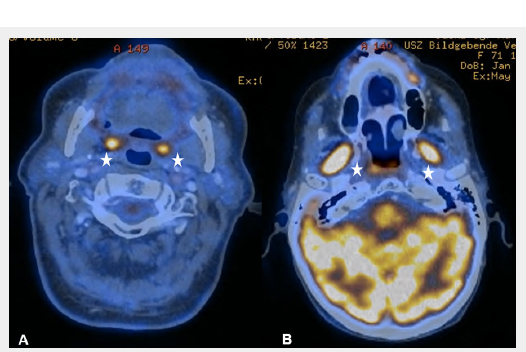
(A) Bilateral physiological uptake in the palatine tonsils in a 83-year old patient with a past medical history of a floor of nose melanoma. (B) Symmetric increased uptake in the muscles of mastication in 71-year old patient treated for tonsillar carcinoma.